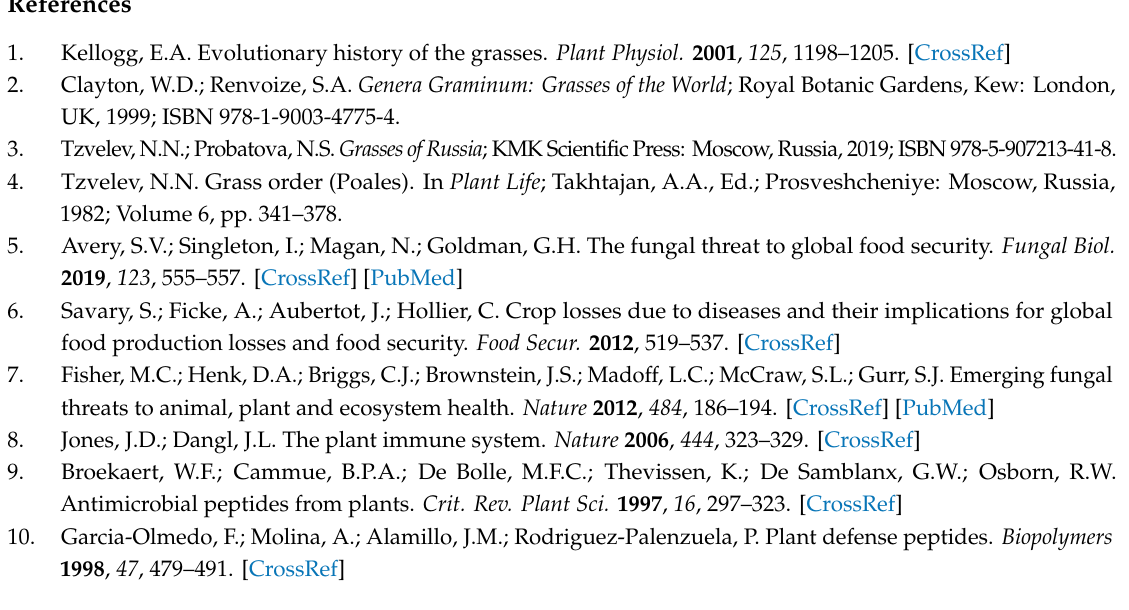
Figure S1: Multiple sequence alignment of T. kiharae and T. monococcum DEFL mature peptides, Figure S2: A phylogenetic tree based on T. aestivum DEFL precursor sequences, Figure S3: A phylogenetic tree based on T. turgidum DEFL precursor sequences, Figure S4: A phylogenetic tree based on T. urartu DEFL precursor sequences, Figure S5: A phylogenetic tree based on A. tauschii spp. strangulata DEFL precursor sequences, Figure S6: A phylogenetic tree based on A. tauschii spp. tauschii DEFL precursor sequences, Figure S7: A phylogenetic tree based on H. vulgare DEFL precursor sequences, Figure S8: A phylogenetic tree based on S. bicolor DEFL precursor sequences, Figure S9: A phylogenetic tree based on O. sativa DEFL precursor sequences, Figure S10: A phylogenetic tree based on Z. mays DEFL precursor sequences, Figure S11: A phylogenetic tree based on A. sativa DEFL precursor sequences, Figure S12: A phylogenetic tree based on P. hallii DEFL precursor sequences, Figure S13: A phylogenetic tree based on P. miliaceum DEFL precursor sequences, Figure S14: A phylogenetic tree based on S. italica DEFL precursor sequences, Figure S15: A phylogenetic tree based on S. viridis DEFL precursor sequences, Figure S16: A phylogenetic tree based on B. distachyon DEFL precursor sequences, Figure S17: Sequences of grass defensins with the RGFRRR motif, Table S1: Accession numbers of grass DEFL sequences, Table S2: Genome characteristics and DEFL number identified by in silico mining in grass species, Table S3: DEFLs of one species with identical mature peptides, Table S4: DEFLs of di ff erent species with identical mature peptides. References [128–140] are cited in the Supplementary